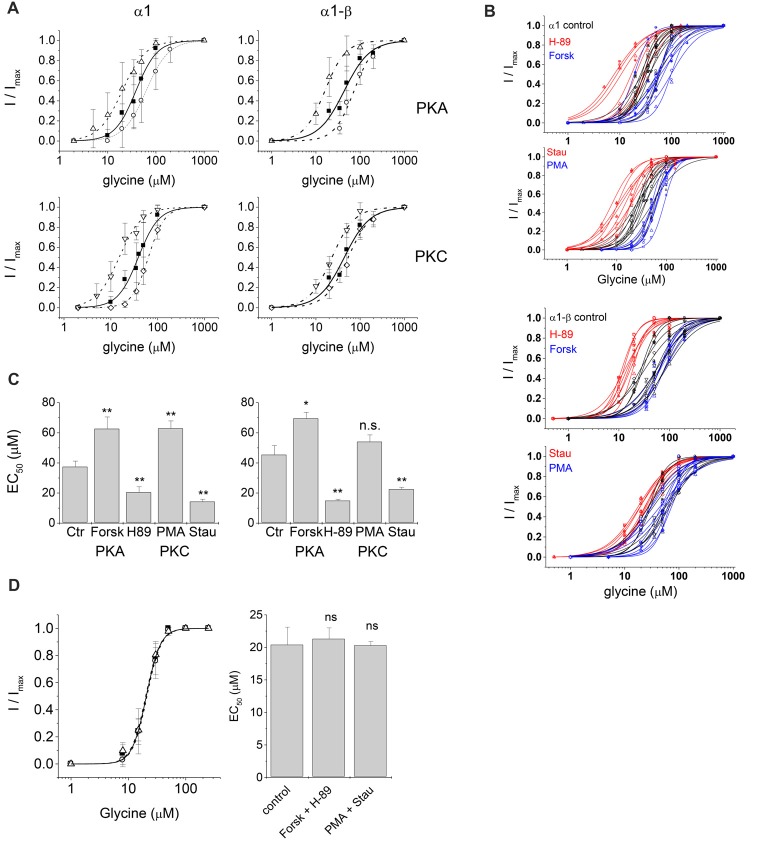
Electrophysiological characterization of glycinergic currents upon protein kinase modulation. Dose-response curves of glycine induced currents in HEK293 cells transfected with GlyR α1 or GlyR α1-β in absence (control) and presence of kinase modulators applied in the intracellular buffer. (A) Control: solid squares, solid line; 0.5 μM Forskolin (Forsk): open circle, dashed line; 0.5 μM H-89: open up triangle, dash-dotted line; 0.5 μM PMA: open diamond, dashed line; 0.5 μM Staurosporine aglycon (Stau): open down triangle, dash-dotted line. All curves were fitted according to the Hill equation. Curves show a rightward shift of the dose-response curve in case of activation due to Forskolin or PMA treatment and a left shift in case of inhibition due to H-89 or Staurosporine aglycon treatment. (B) Single cell EC50 data of control (black), PKA and PKC activator (blue) and PKA and PKC inhibitor (red). (C) Summary of whole-cell current characteristics for PKA and PKC modulation. Significance levels for the comparison of EC50 (p-values, one-way ANOVA) are indicated (*p ≤ 0.05, **p ≤ 0.01, n.s., not significant). All changes in EC50 values were significant except PMA treatment for heteromeric α1-β GlyRs. Here we detected an increase in EC50 values, however due to the daily variability in EC50 values this effect was not statistically significant. (D) Simultaneous intracellular application of PKA modulators. Forskolin and H-89, and PKC modulators PMA and Staurosporine aglycon. All modulators were used at a concentration of 0.25 μM. Left panel: concentration-response curves: solid squares: control, no modulators; open circles: Forskolin/H-89; open triangles: PMA/Staurosporine aglycon. Right panel: summary of results in a bar graph. No significant changes from control were observed, indicating that indeed action of PKA- and PKC agonists were counteracted by inhibitors (n.s., not significant).